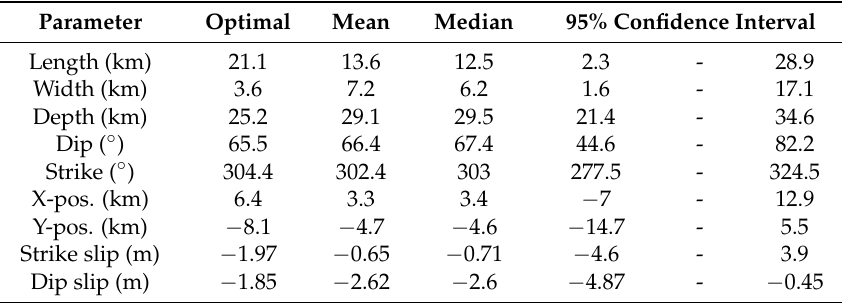
Figure 5. Fault parameter uncertainties and trade-offs for the uniform slip InSAR model of the 3 April 2017 M w 6.5 earthquake. Uncertainties and trade-offs are calculated using a Monte Carlo approach from the inversion of 1 × 10 6 datasets perturbed with realistic noise. Histograms show the a-posteriori probability distribution of fault parameters, and scatterplots show trade-offs between parameters. The a-priori bounds are listed in Table 1. Table 2. Optimal fault parameters and range of variability.